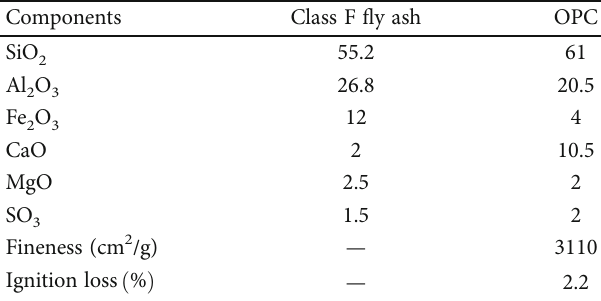
Figure 1: The geographical location of the test site. Table 1: The chemical components of fl y ash and